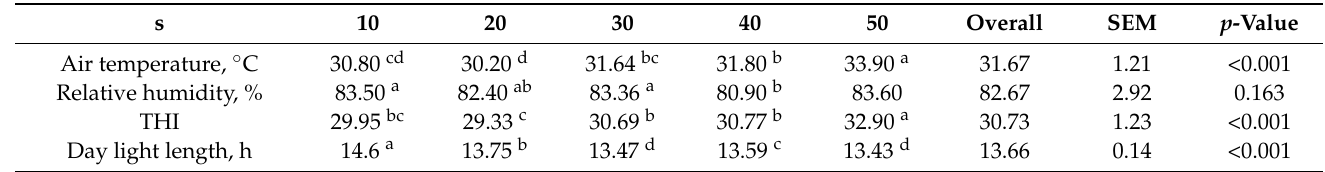
Table 4. Changes in (mean ± SEM) ambient temperature ( ◦ C), relative humidity (%), temperature–humidity index (THI) and photoperiod (h) during the 10 d intervals of the experimental period (July–mid-August).